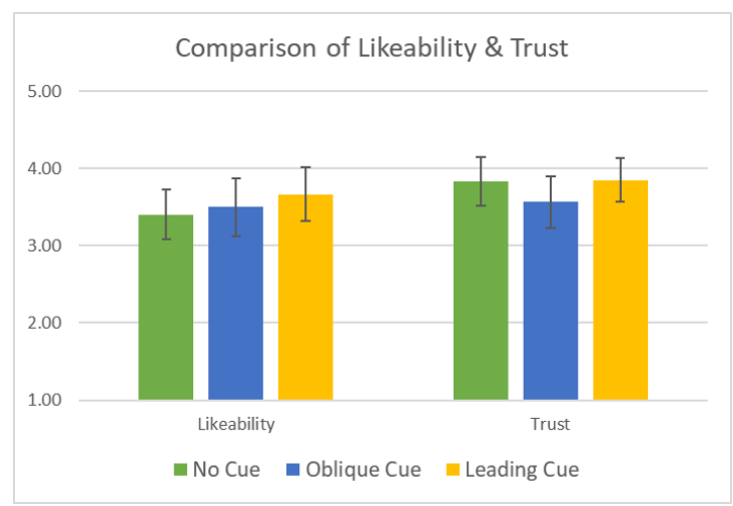
Figure 4. Comparison of likeability and trust.